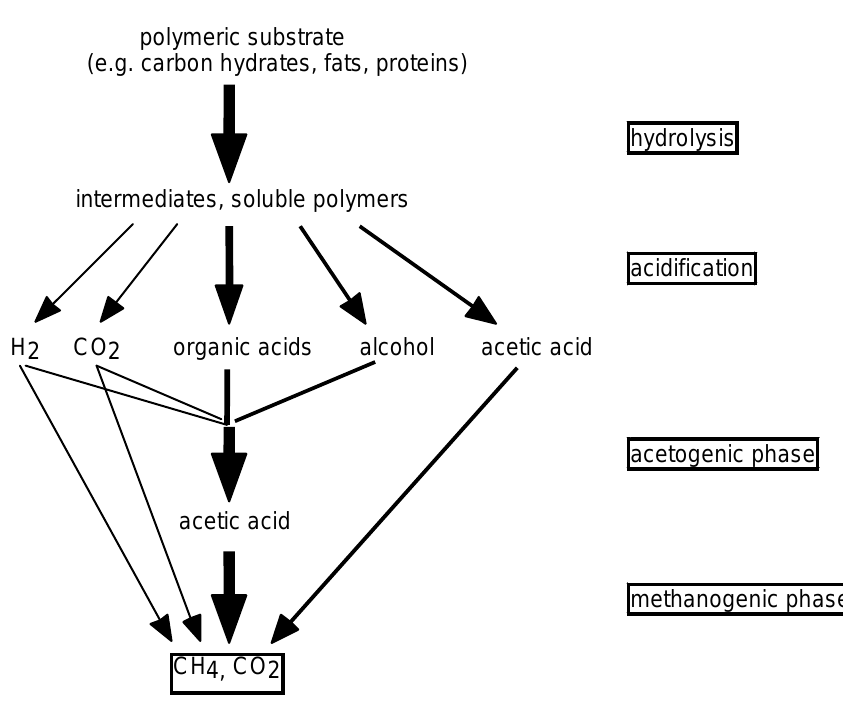
Figure 3 . Anaerobic biodegradation pathway